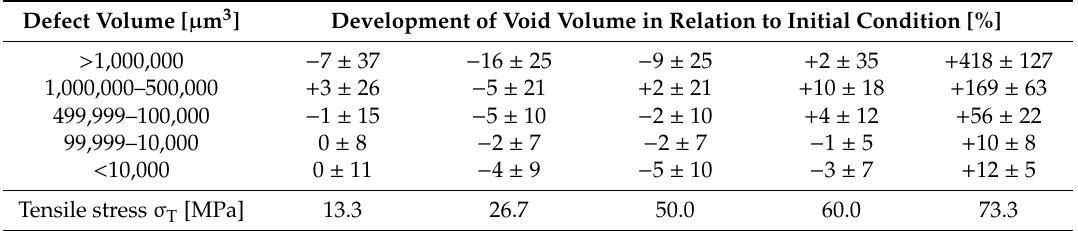
Table 2. Percentage development of void volume in the specimen’s gauge length at di ff erent tensile loads in an in situ tensile